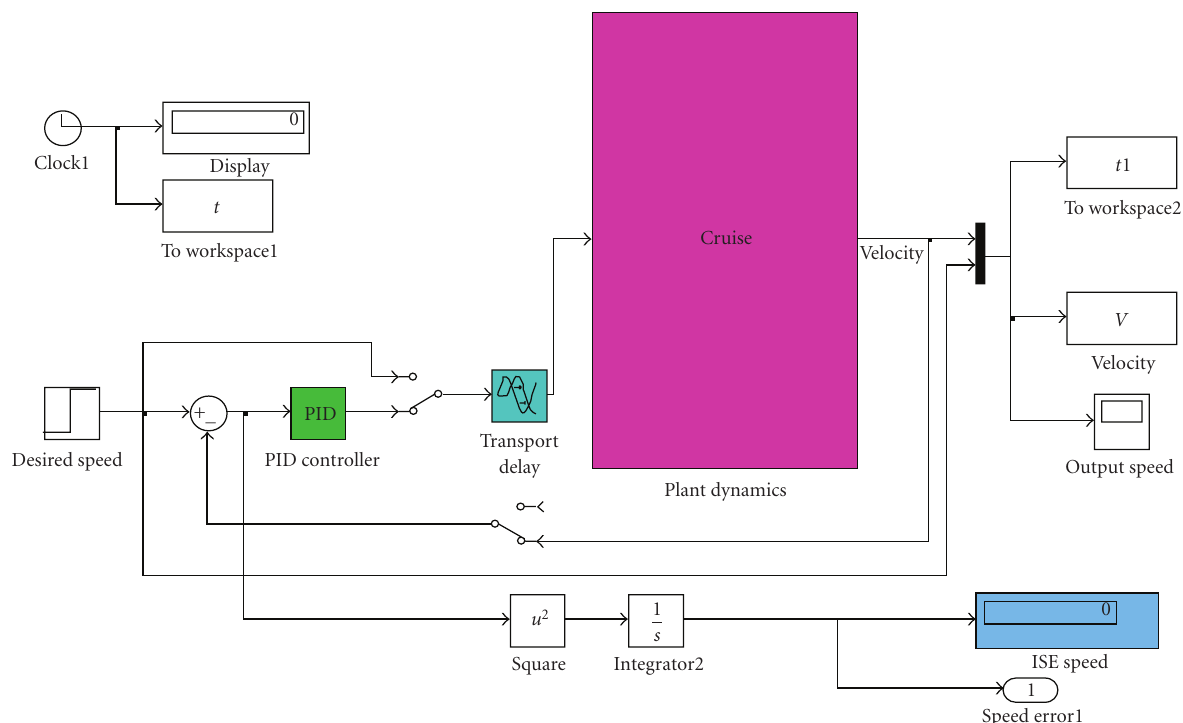
Figure 4: MATLAB SIMULINK block diagram for the linear model of cruise control system using PID controller.